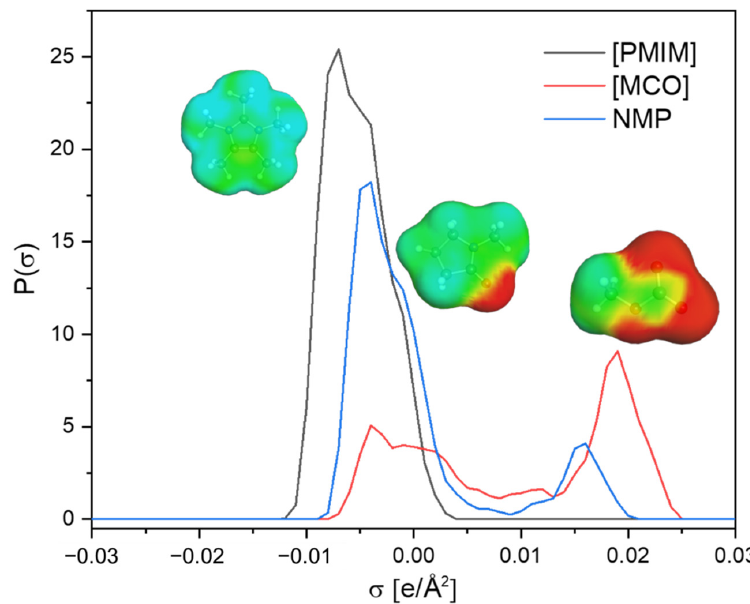
Figure 9. σ -Profile analysis of [PMIM][MCO] and NMP.